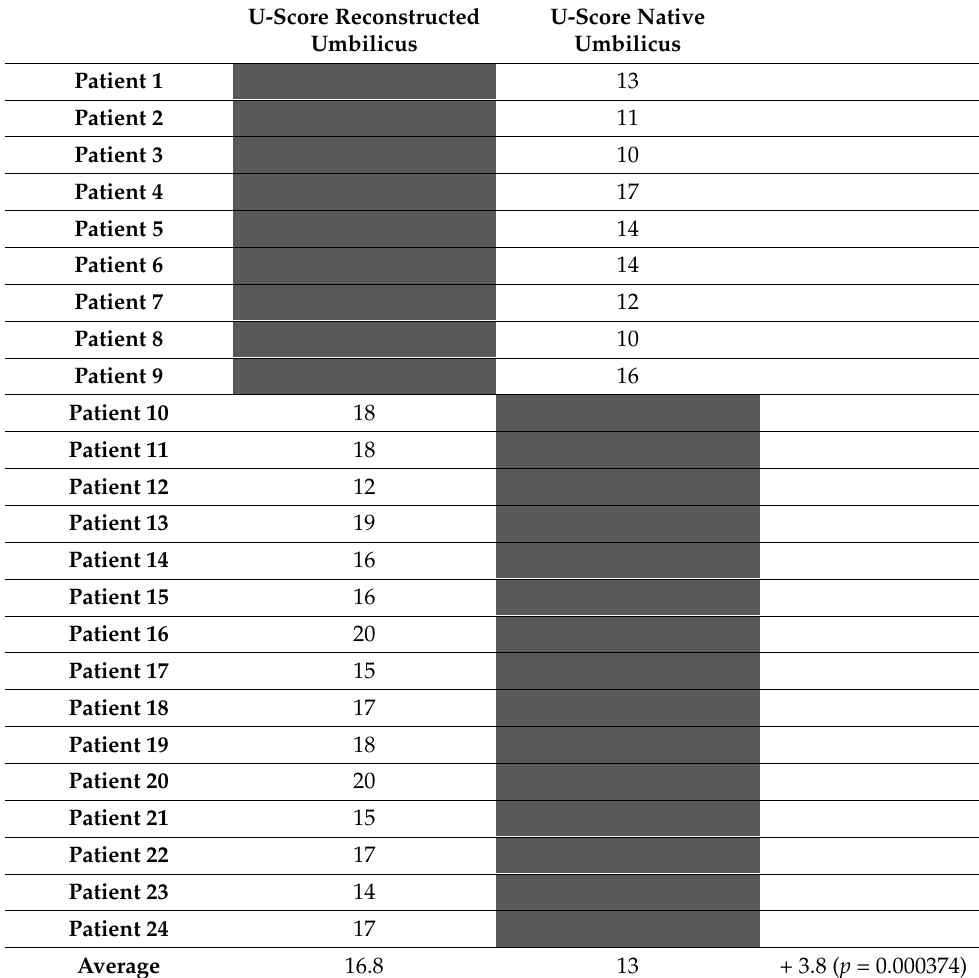
Table 4. Evaluation with the U-score